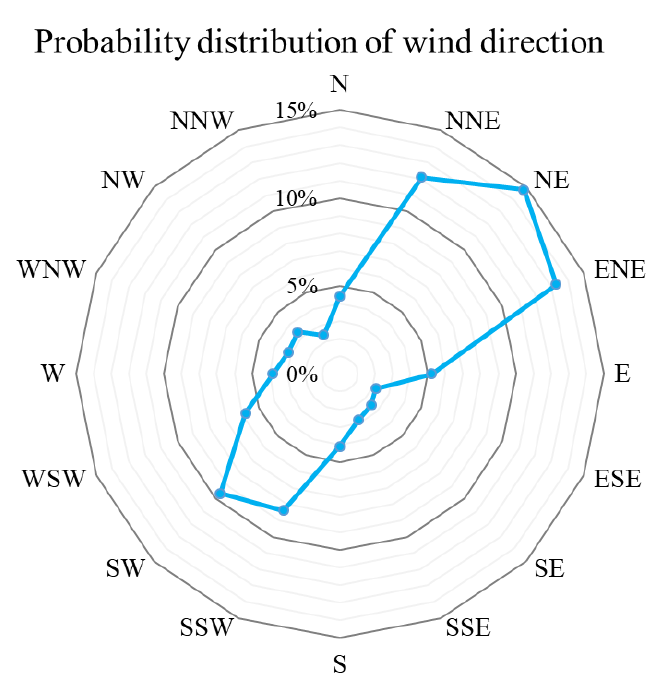
Figure 3. Probability distribution of wind direction in Xi’an, China.